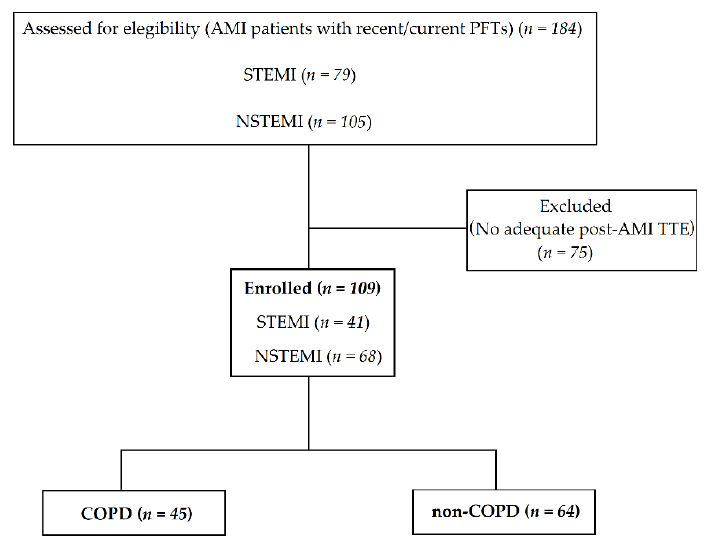
Figure 1. Consort flow chart showing how the analytical sample was derived from the patients who were assessed for eligibility. Abbreviations: AMI, acute myocardial infarction; COPD, chronic obstructive pulmonary disease; NSTEMI, non ST-segment elevation myocardial infarction; PFTs, pulmonary function tests; STEMI, ST-segment elevation myocardial infarction; TTE, transthoracic